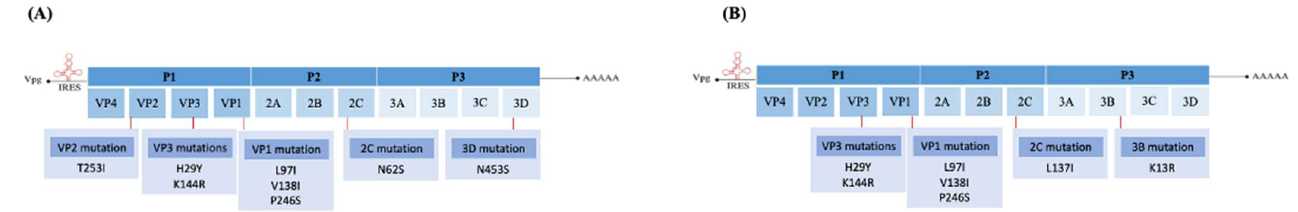
Figure 4. Six-well plates containing Vero cells with 70–80% confluency were infected with the EV-